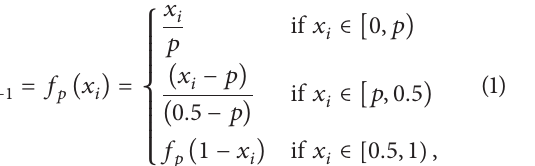
Algorithm 1 (shuffling of an image by PWLCM). Consider the following